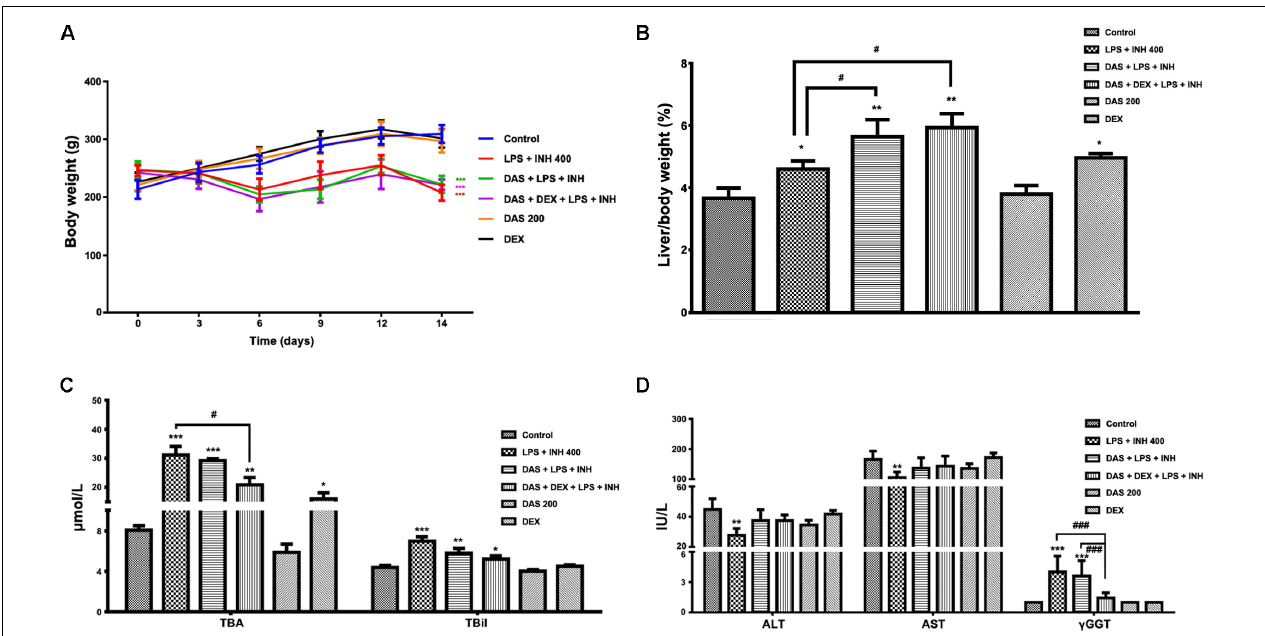
FIGURE 1 | Effects of DAS and DEX administration on liver injury parameters induced by INH/LPS co-administration. SD rats were intragastrically treated with DAS (200 mg/kg) starting from 3 days before INH administration and daily continued throughout the experimental period. INH 400 mg/kg was intragastrically administered for 14 consecutive days 1 h after DAS, whereas LPS (2 mg/kg) was given as intravenous bolus dose at day 14, 2 h before the last INH dose. DEX (4 mg/kg) was also given as single intraperitoneal dose at day 14, 1 h prior LPS administration. (A) Alteration in body weight. (B) Liver coefficient after drugs treatment. (C) Impact on serum TBA and TBil levels. (D) Alterations in serum ALT, AST, and γ GGT levels. Data are presented as mean ± SD, n = 7 for each bar, ∗ P < 0.05, ∗∗ P < 0.01, ∗∗∗ P < 0.001 versus control, # P < 0.05, ## P < 0.01, ### P < 0.001 versus INH/LPS or DAS/INH/LPS